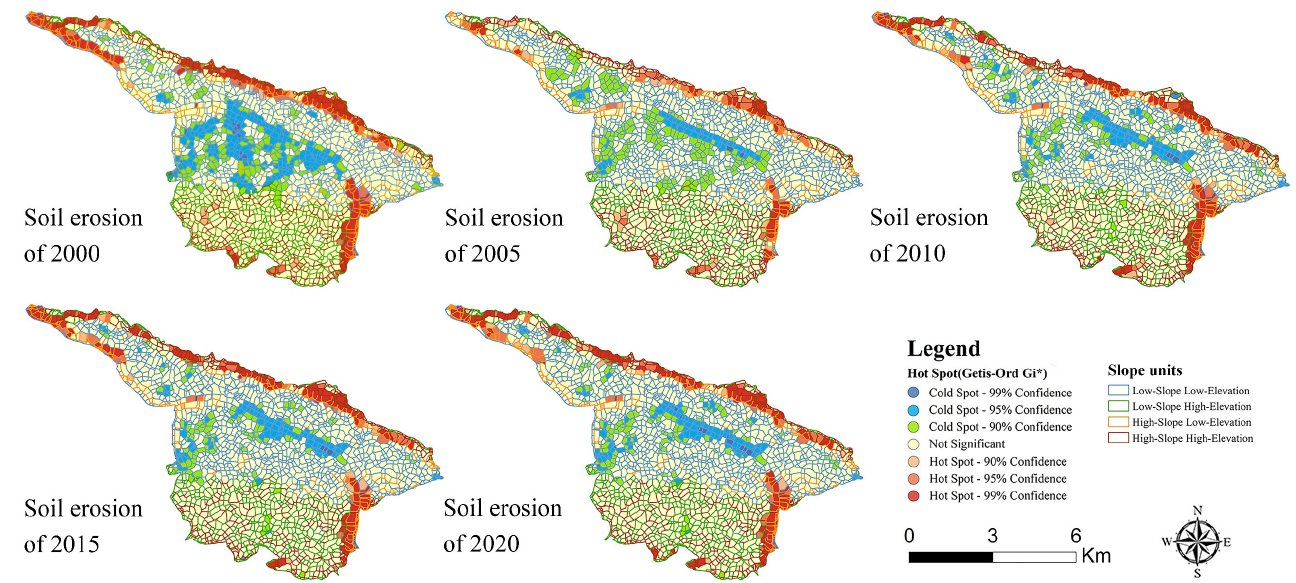
Figure 6. Hotspot analysis under different slope units.